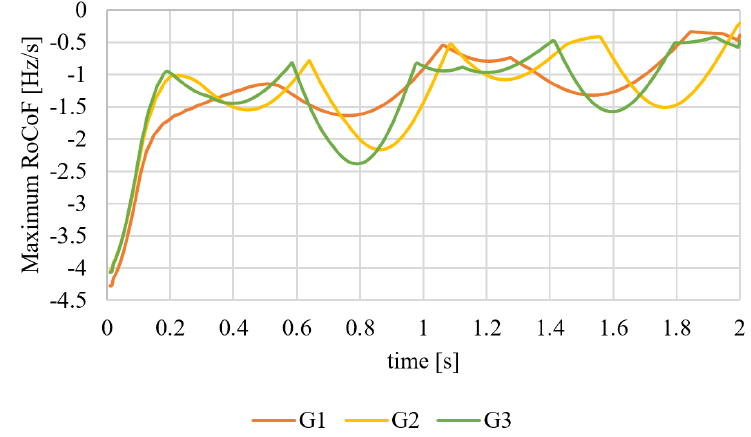
Figure 5. Maximum RoCoF over time for each network in Figure